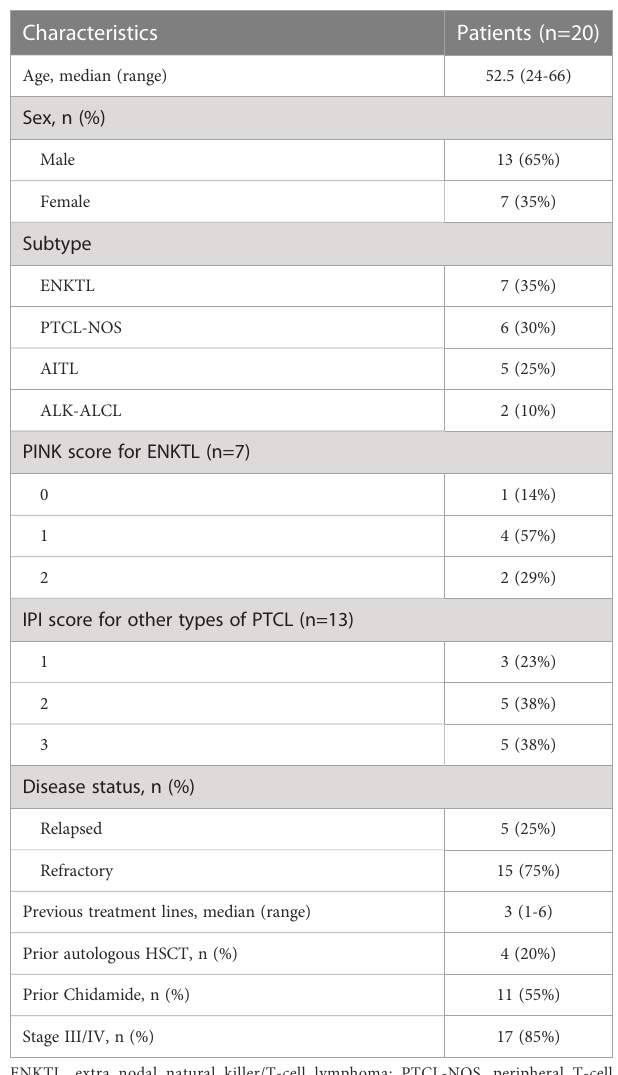
TABLE 1 Baseline characteristics of patients.